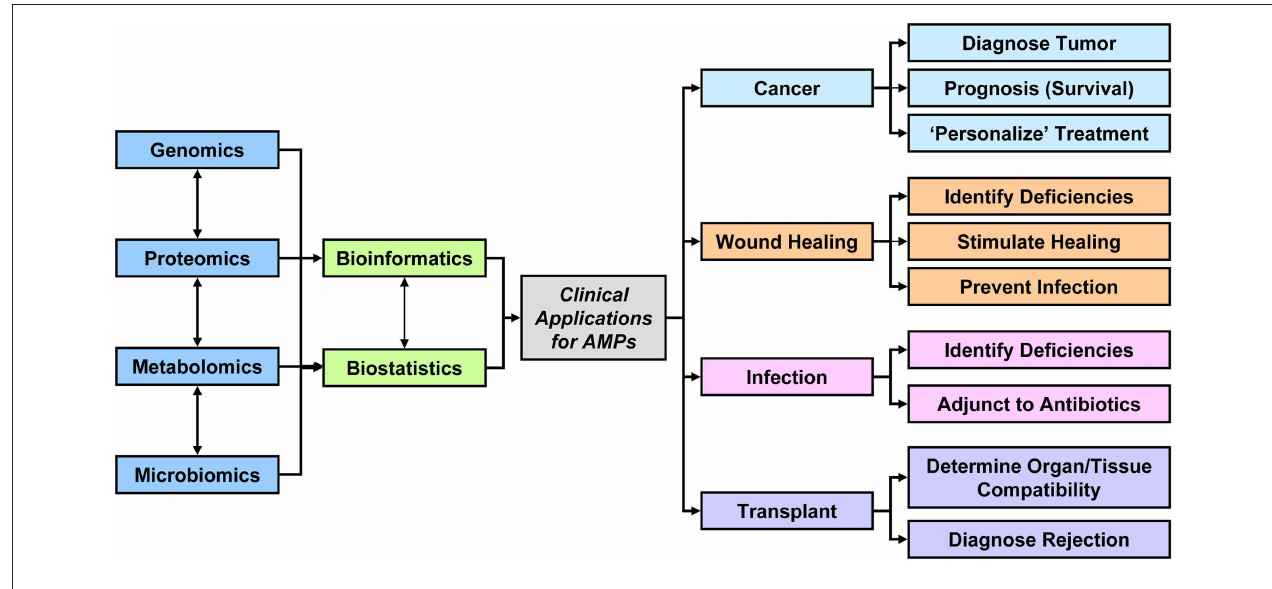
FIgure 1 | Data acquired from the combination of genomics, proteomics, metabolomics, microbiomics, and other omics technologies either directly investigating AMPs or examining related parameters may be